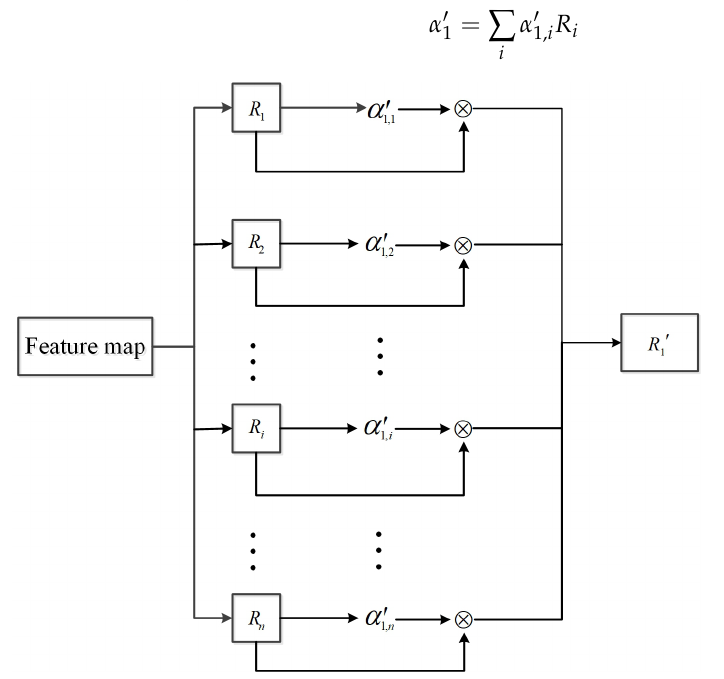
Figure 8. Sketch of calculating the output